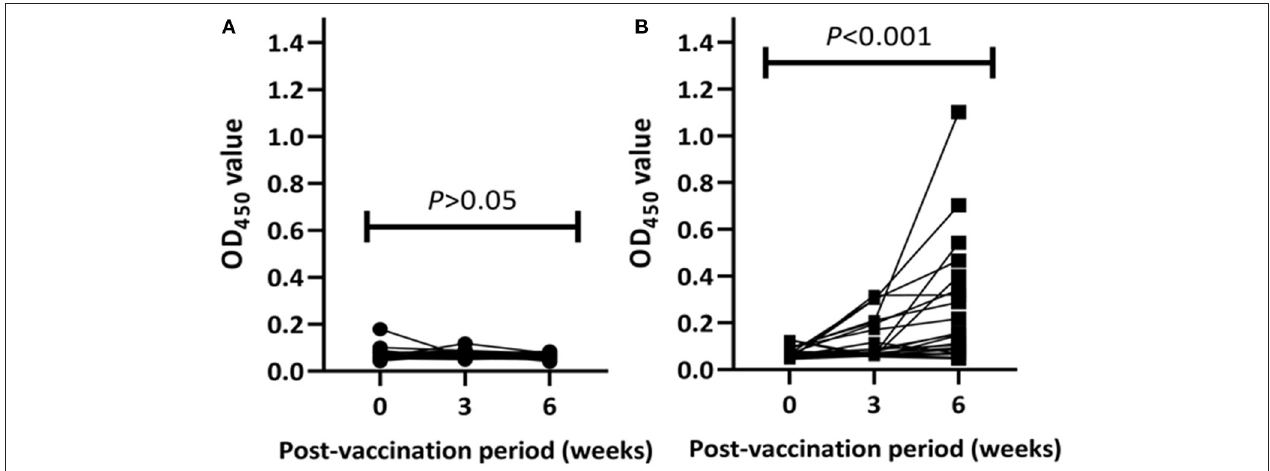
FIGURE 3 | Post-vaccination antibody responses in the experimental calves. Kinetics M. bovis specific antibody responses in individual control (A) and vaccinated (B) calves are presented in the figure. The antibody response was expressed as optical density (OD) value at 450nm and the values of each animal are connected with lines. The antibody response in the control calves remained at low levels throughout the post-vaccination period while the response in the vaccinated calves increased significantly at week 6 post-vaccination (Friedman test, p < 001).